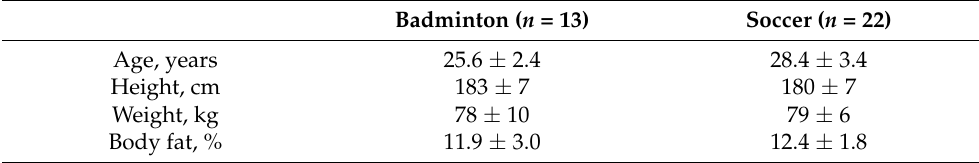
Table 1. Participants’ characteristics.